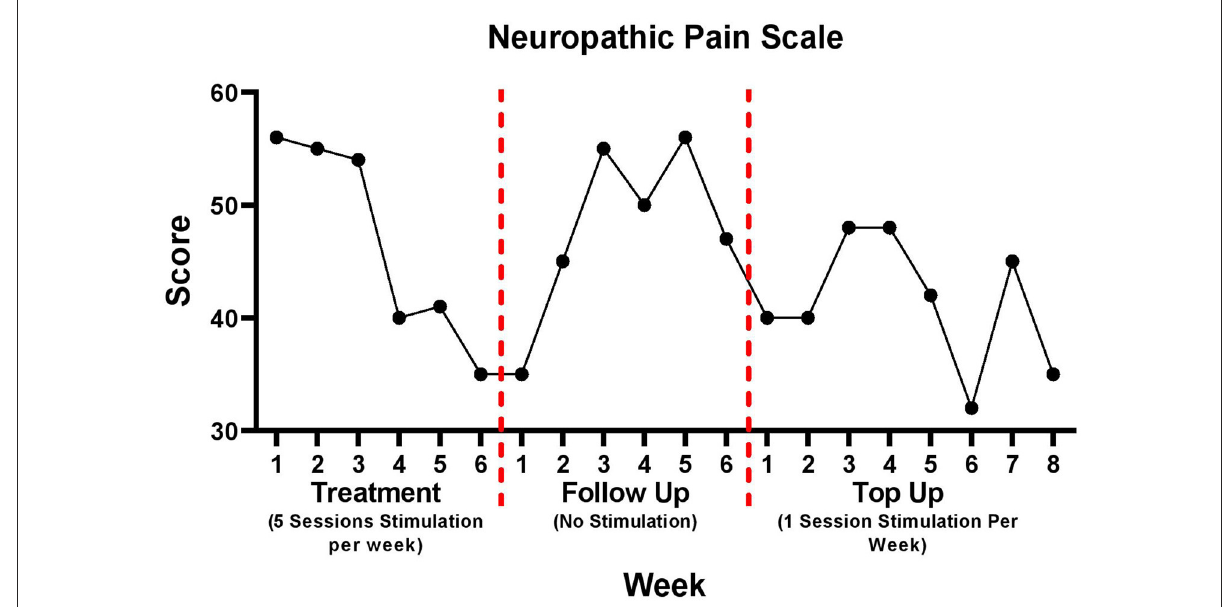
FIGURE3 Neuropathic pain scale data for treatment, follow up, and top up sessions. There was a 5-week period between follow up week 6 and top up session week 1.